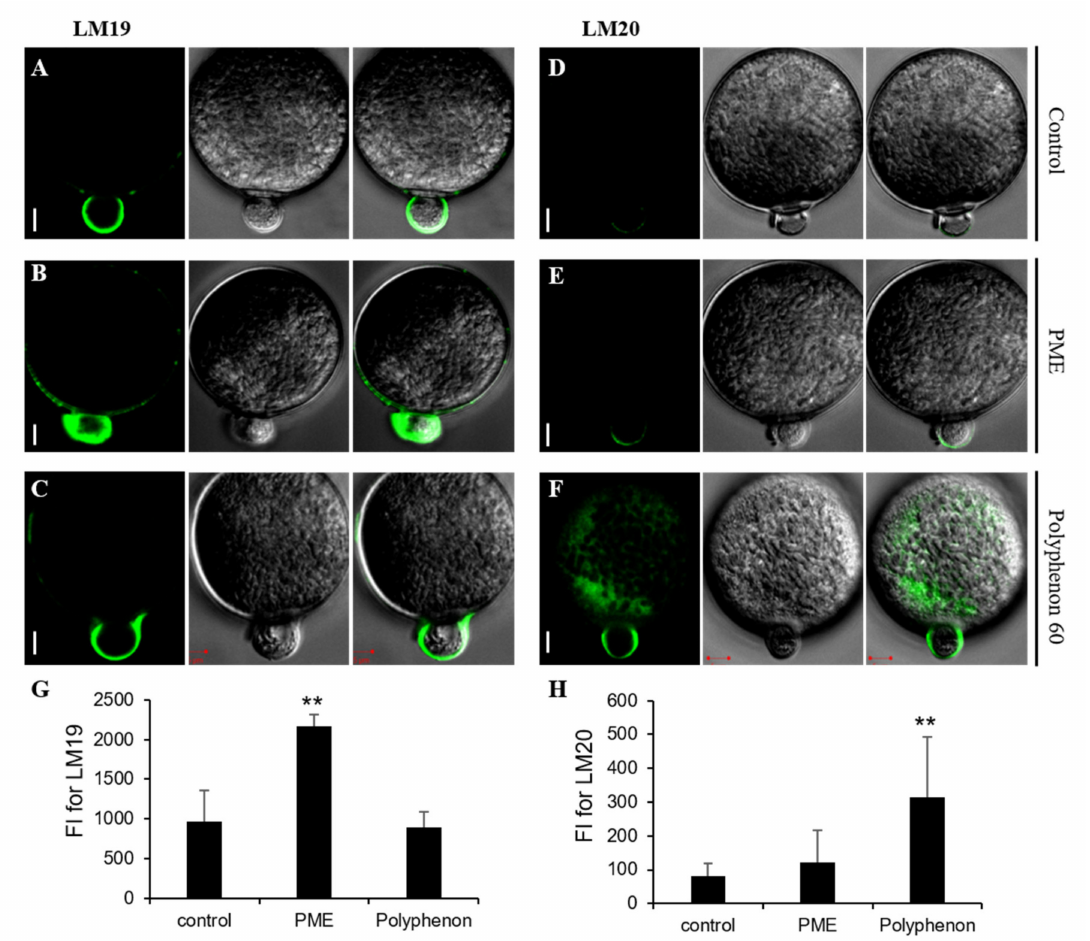
Figure 2. Immunodetection of pectins upon pollen germination. Pollen grains were probed with the monoclonal antibodies LM19 and LM20. LM19 is used to indicate pectins with a low level of methylesterification whereas LM20 binds to pectins with a high level of methylesterification. ( A ) Control: LM19-labeling signals upon pollen germination. ( B ) LM19-labeling signals of PME-treated pollen grain. ( C ) LM19-labeling signals of the Polyphenon 60-treated pollen grain. ( D ) Control: LM20-labeling signals upon pollen germination. ( E ) LM20-labeling signals of the PME-treated pollen grain. ( F ) LM20-labeling signals of the Polyphenon 60-treated pollen grain. Moderate concentration of PME (2 U / mL) was added onto the germination medium. ( G ) Quantification analysis of LM19 labeling. ( H ) Quantification analysis of LM20 labeling. FI, fluorescence intensity. All error bars represent SD of at least twenty independent experiments. Student’s t test: ** p < 0.01. Scale bars = 5 µ